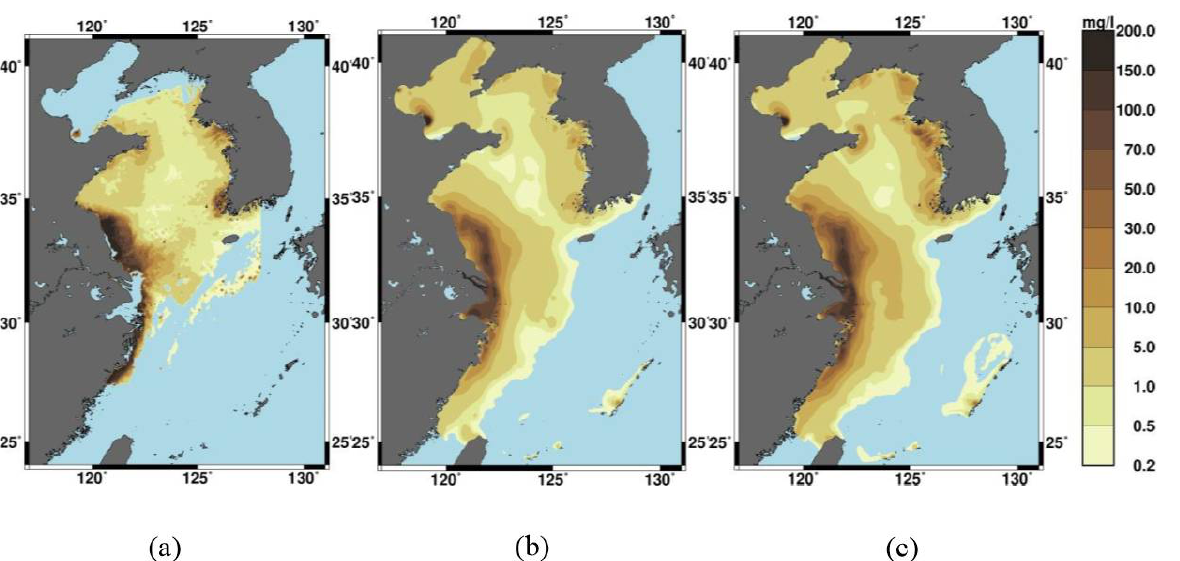
Figure 9. Surface distribution of SSC from ( a ) GOCI remote sensing data; ( b ) simulation without waves; ( c ) simulation with waves for 21 March 2013.